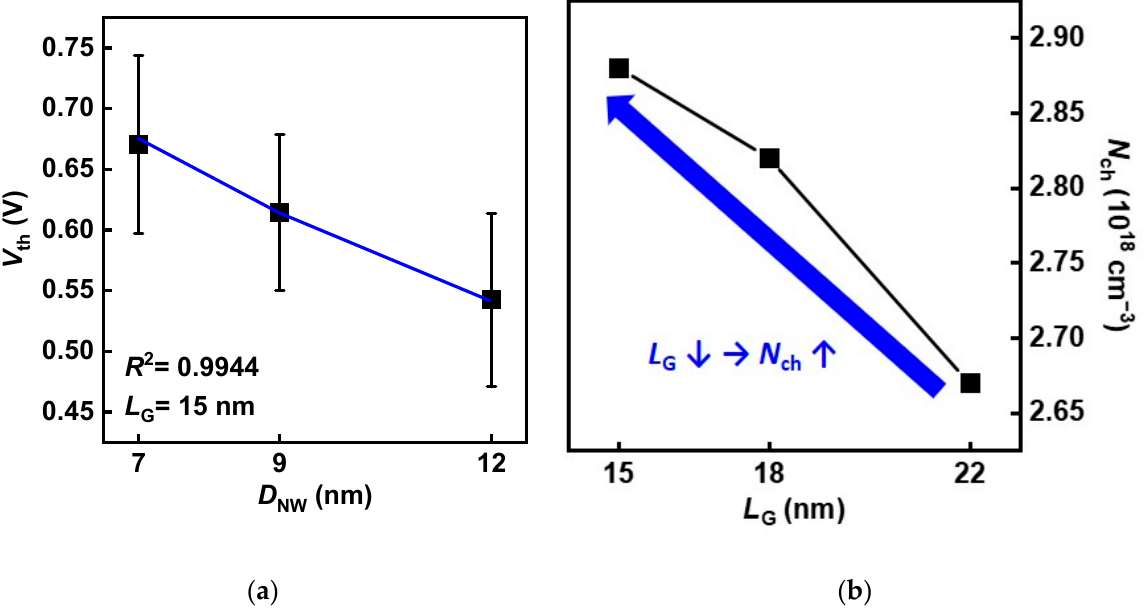
Figure 5. ( a ) Measured (black dots) and modeled (blue line) values of V th as a function of D NW . ( b ) Extracted N ch as a function of L G .